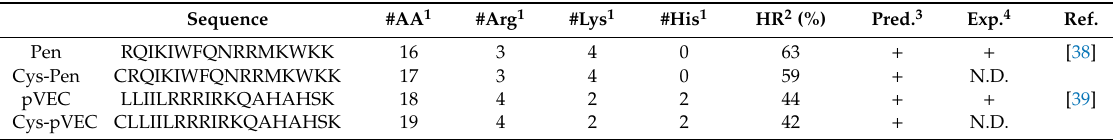
Table 3. Electronic and hydrophilic properties of the studied CPP.